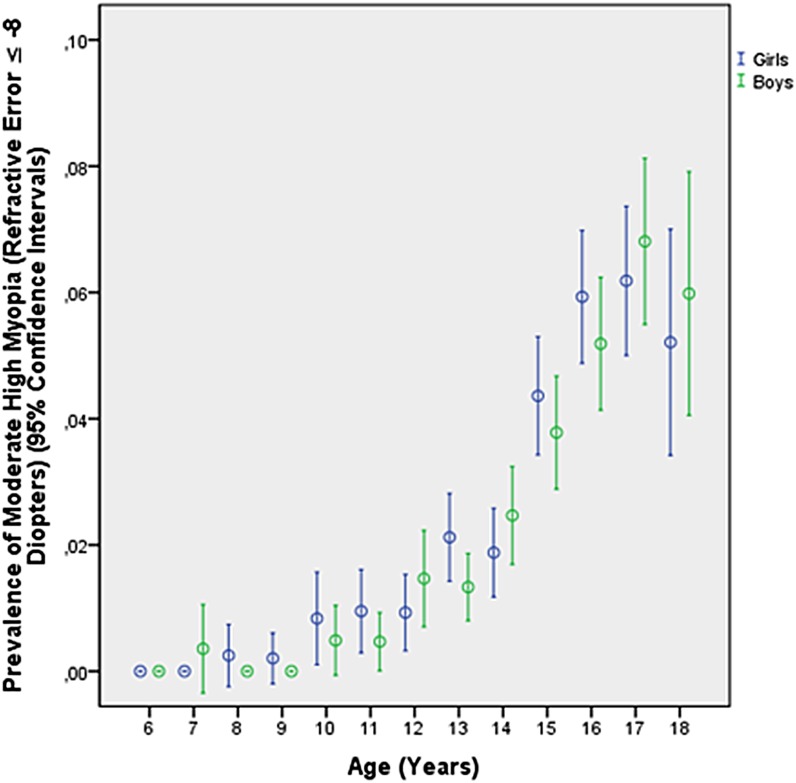
Diagram showing the prevalence of moderate high myopia (myopic refractive error ≥-8.00 diopters) in the Greater Beijing School Children Myopia Study 2016.